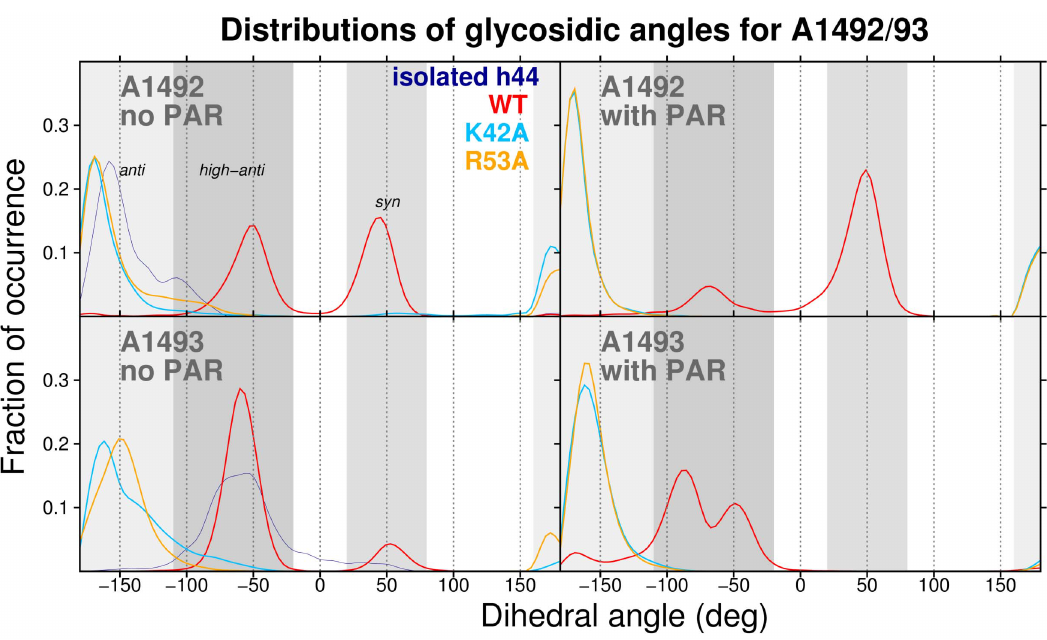
Figure 4. MD-derived distributions of glycosidic angles (in deg) for A1492 and A1493. The anti , high-anti and syn conformational regions are shaded. The data are cumulative from three independent MD trajectories per simulation system variant.